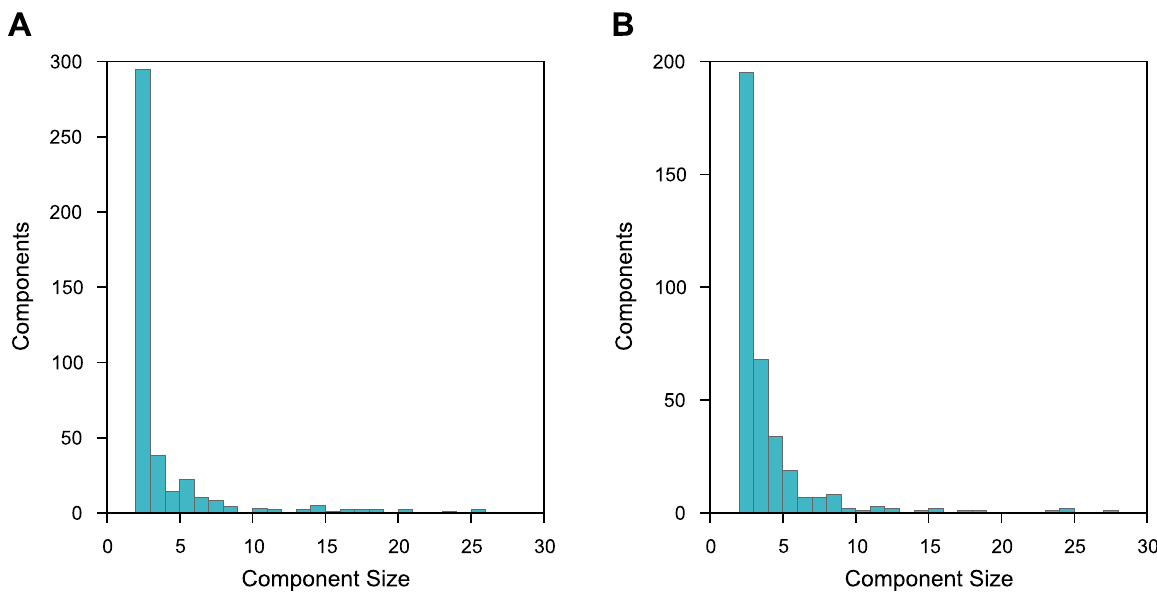
Figure 6. Histograms of sizes of connected components (in DAG nodes) for yeast (A) and human (B). Only the components with fewer than 30 nodes are shown. This excludes larger initial components (four in both yeast and human).